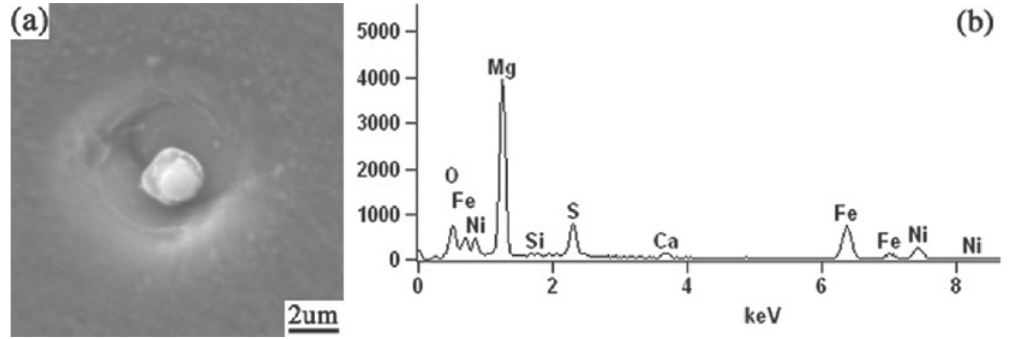
Fig. 5: SEM morphology and EDS analysis of the typical MgO-MgS composite particle. (a) SEM morphology; (b) EDS analysis